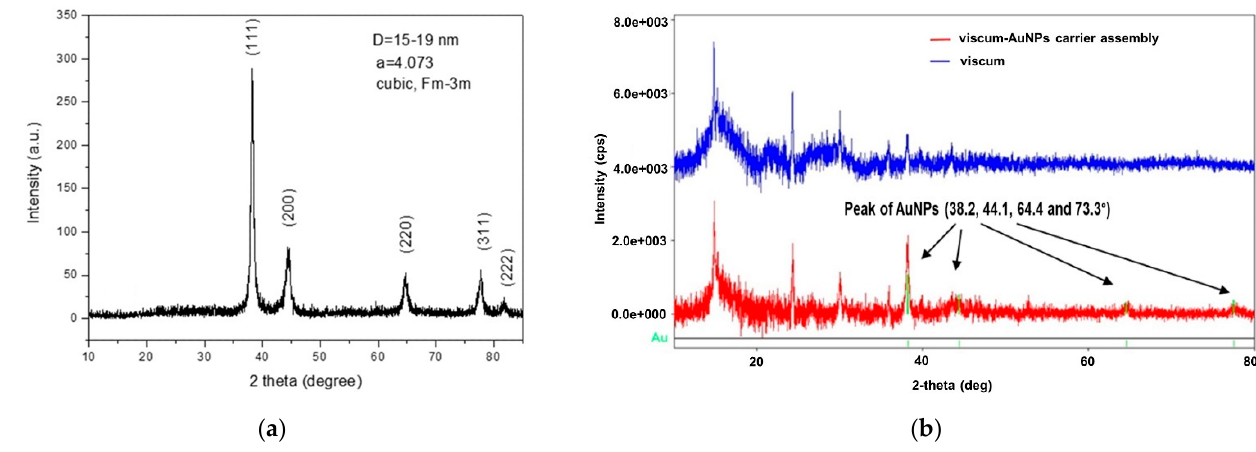
Figure 4. ( a ) Powder XRD patterns of the AuNPs; ( b ) XRD patterns of the viscum sample and engineered viscum–AuNPs carrier assembly.